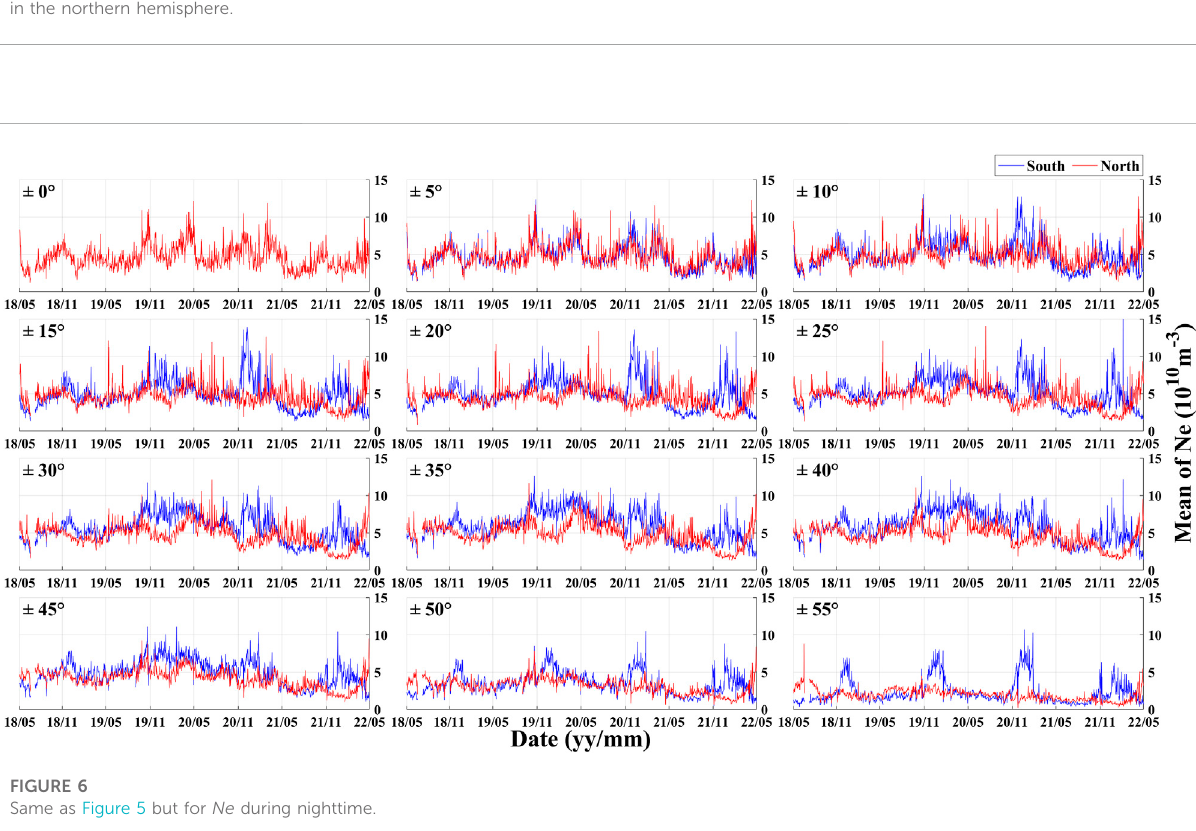
opposite, with maximum at Dec. solstice and minimum at the Jun. solstice in the SH, and the opposite in NH. The annual variation of Ne starts to weaken since ±45 ° Mlat. It should be noted that the value of